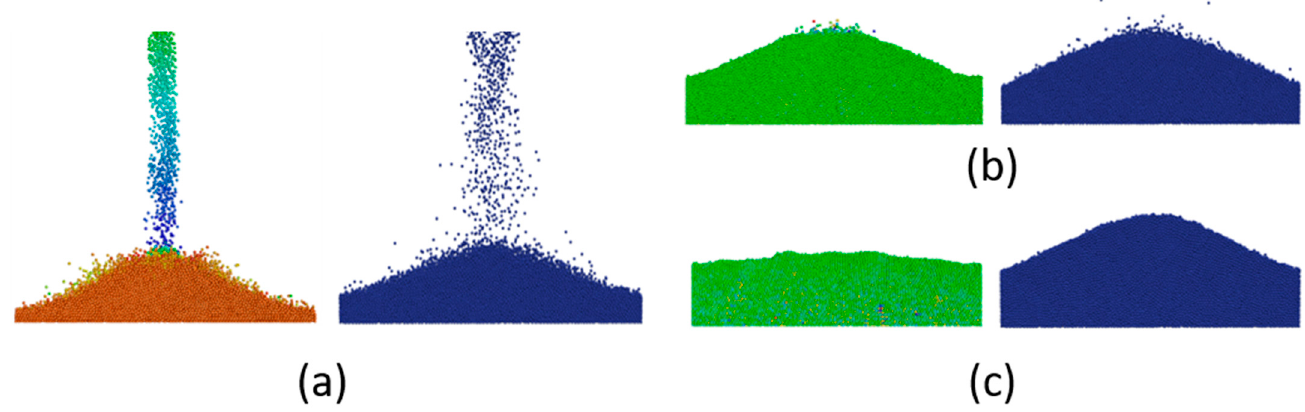
Figure 1. DEM simulations of particles falling through a slit in a commercial program (left) and MFiX (right): ( a ) particles falling; ( b ) all particles have fallen; ( c ) the system has stabilized.